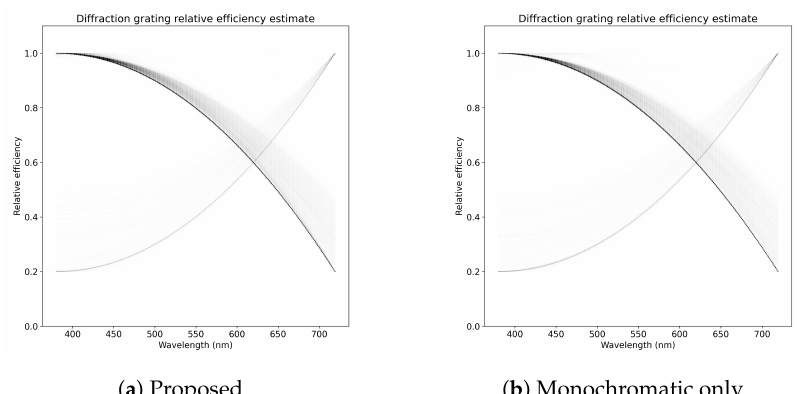
Figure 8. Plot of all ensemble iterates of the diffraction grating efficiency estimate for proposed and monochromatic only methods. There are slight differences in the distribution of the samples over the wavelengths, but, overall, these methods produce estimates that are consistent with each other. A small number of ensemble iterates have converged to an optimum where the grating efficiency is greater for longer than smaller